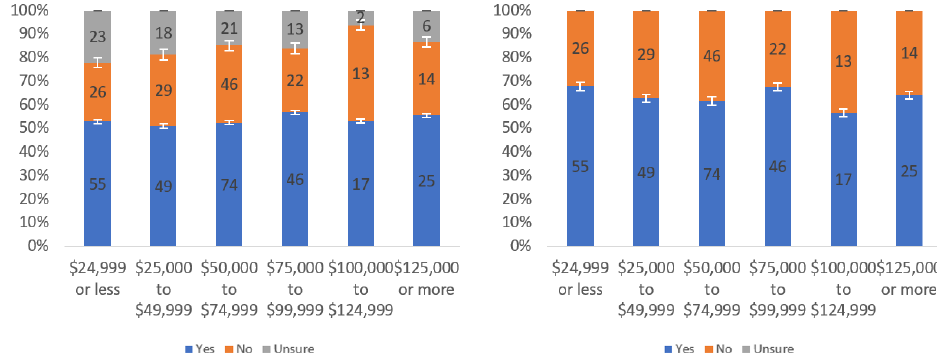
Figure A7. Responses regarding respondents’ willingness to review by income level including ( left ) and excluding ( right ) unsure responses.